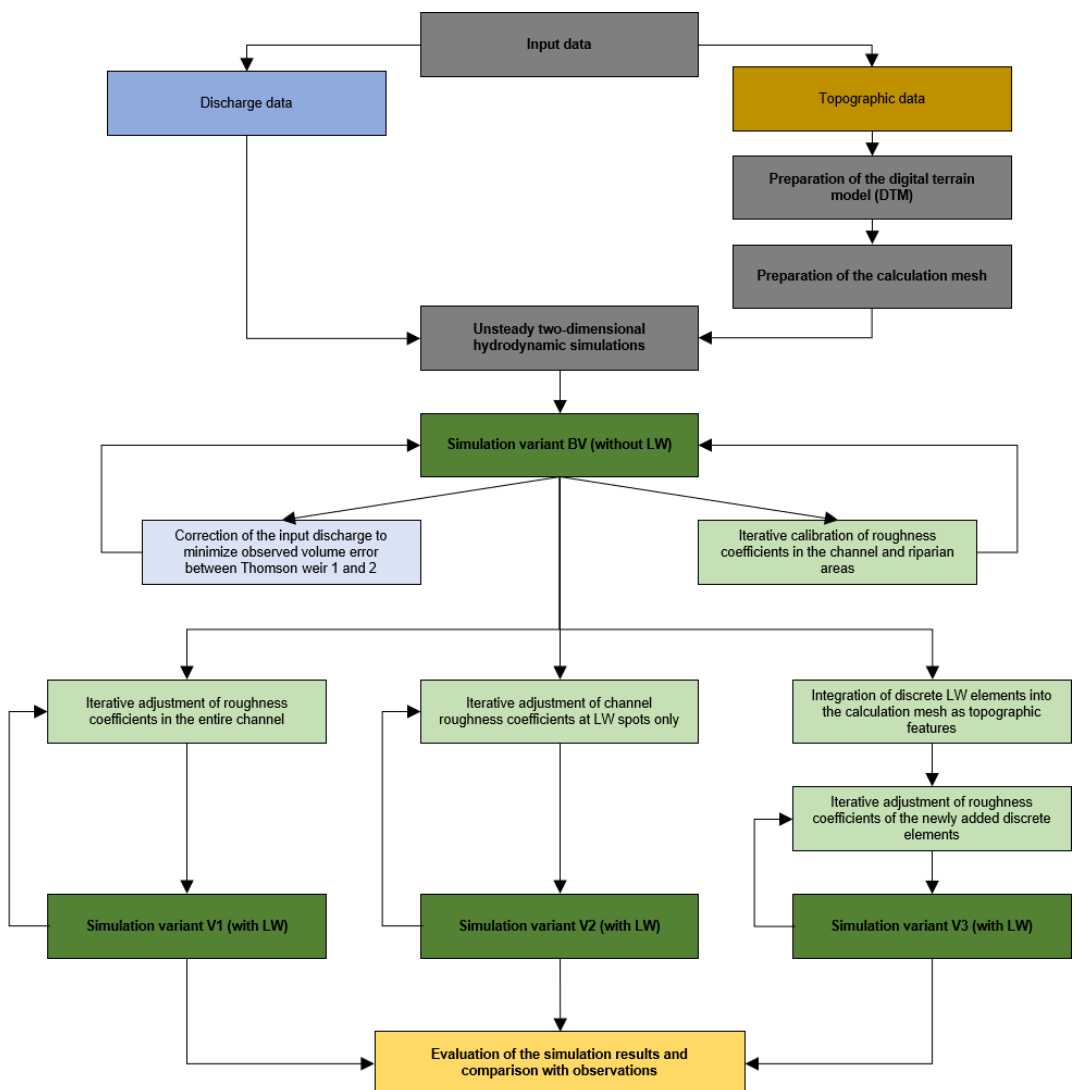
Figure 3. Schematic illustration of the methodological